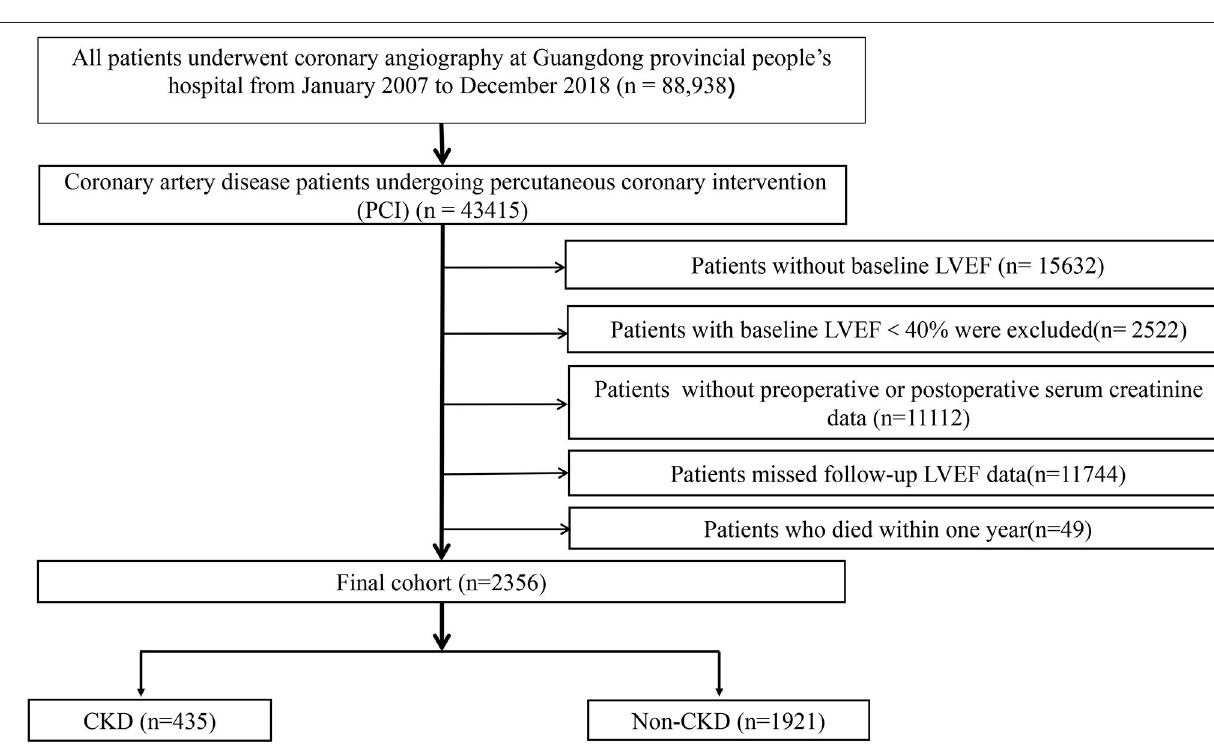
62.7 ± 10.7 years). Among the patients, 1,421 (60.3%)